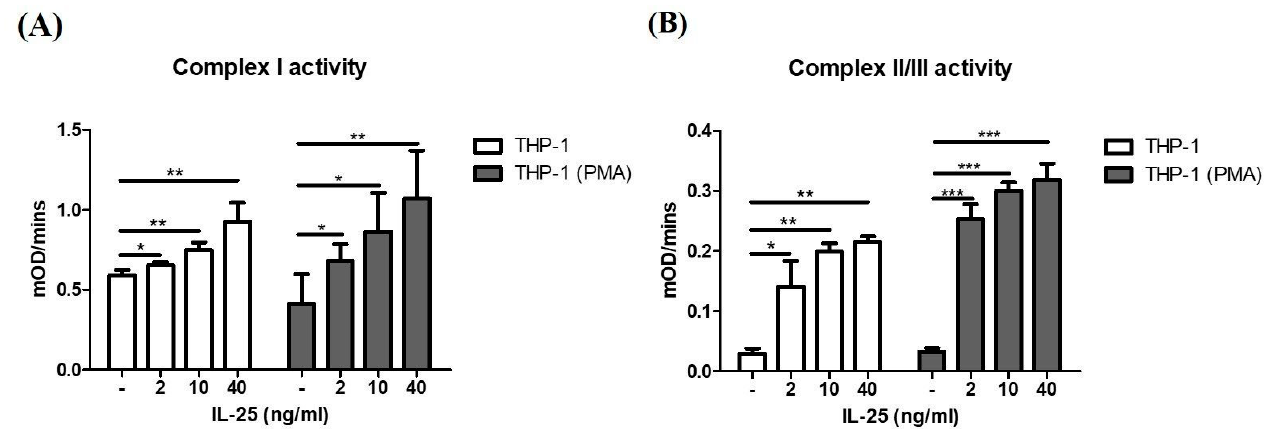
Figure 2. IL-25 increased mitochondria complex activity in THP-1 cells and THP-1 derived macrophages. THP-1 cells (white bar) and THP-1 derived macrophages (gray bar) were treated with medium alone or IL-25 (2, 10, and 40 ng/mL) for 2 h. The activity of complex I ( A ) and com- plex II/III ( B ) by IL-25 treatment were determined. * p < 0.05, ** p < 0.01, and *** p < 0.001; n = 4, means ±